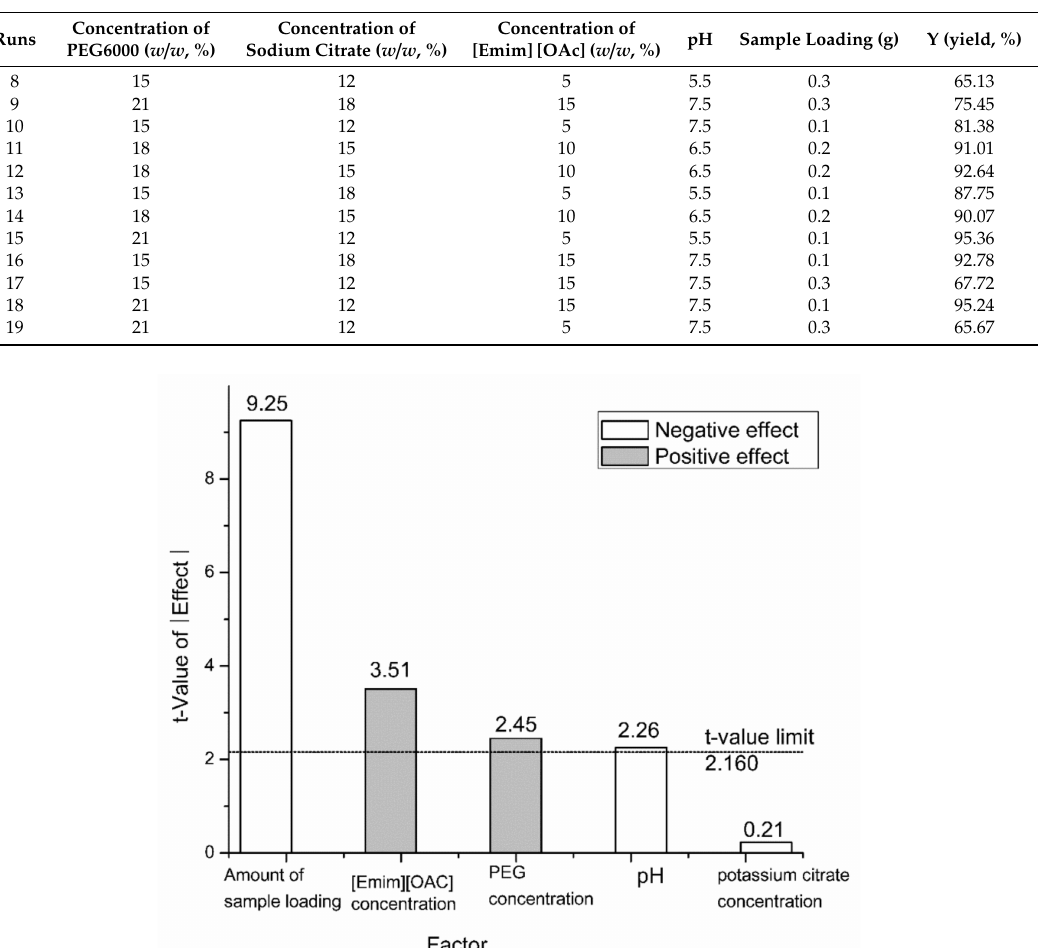
Figure 2. The influence of the main e ff ects on the yield of capsaicin were analyzed with a Pareto chart. The line of the t-value limit is a reference. The factor has a significant contribution to the response as the t -value above the reference line ( p < 0.05). Gray indicates that the e ff ect of this factor is positive, and white indicates that the e ff ect of this factor is negative.